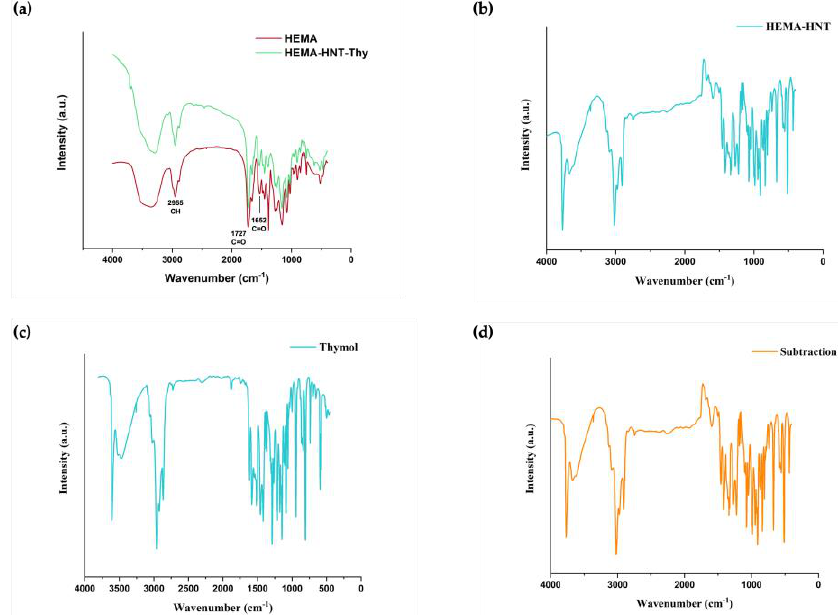
Figure 3. FTIR spectra of ( a ) HEMA and HEMA-HNT/Thy; ( b ) HEMA-HNT; ( c ) Thy; ( d ) HEMA-HNT/Thy with HEMA-HNT subtraction.